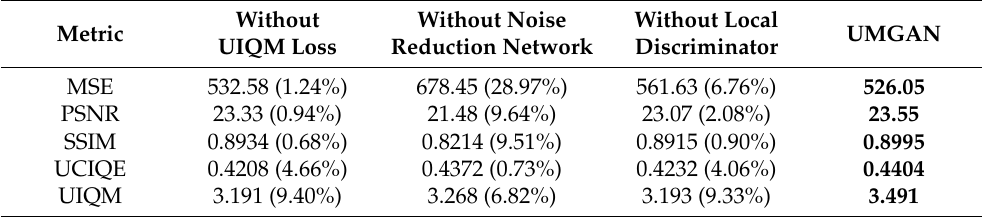
Table 1. Quantitative evaluation of ablation experiments (best scores are bolded; the numbers in parentheses represent the percentage boost after adding the module).